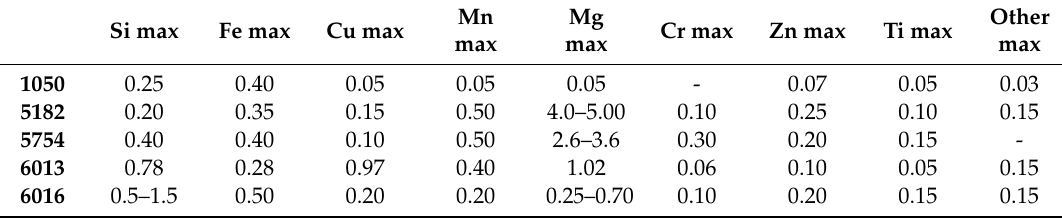
Table 1. Aluminum alloys, chemical compositions (%at.)